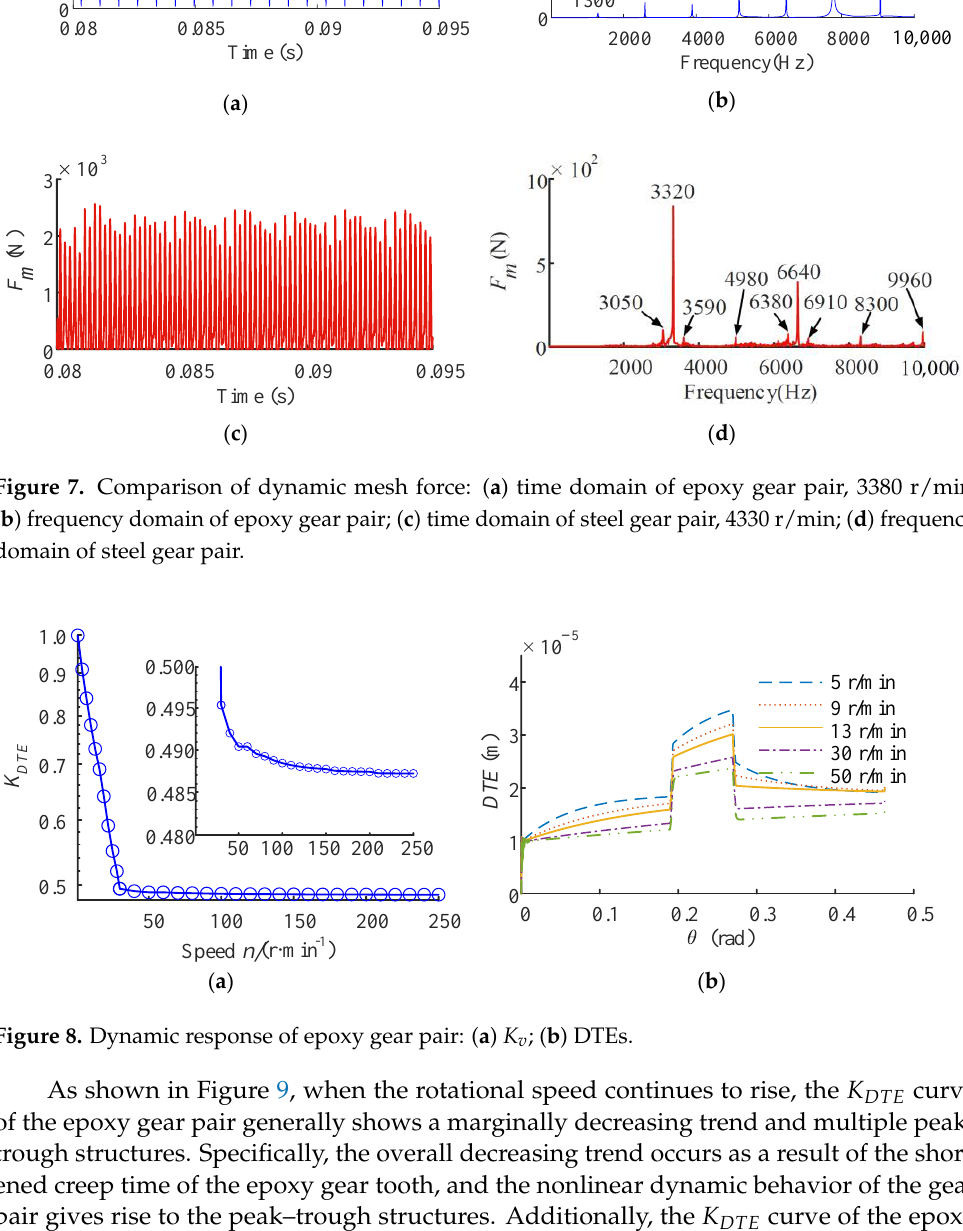
Figure 7. Comparison of dynamic mesh force: ( a ) time domain of epoxy gear pair, 3380 r/min; ( b ) frequency domain of epoxy gear pair; ( c ) time domain of steel gear pair, 4330 r/min; ( d ) frequency domain of steel gear pair .